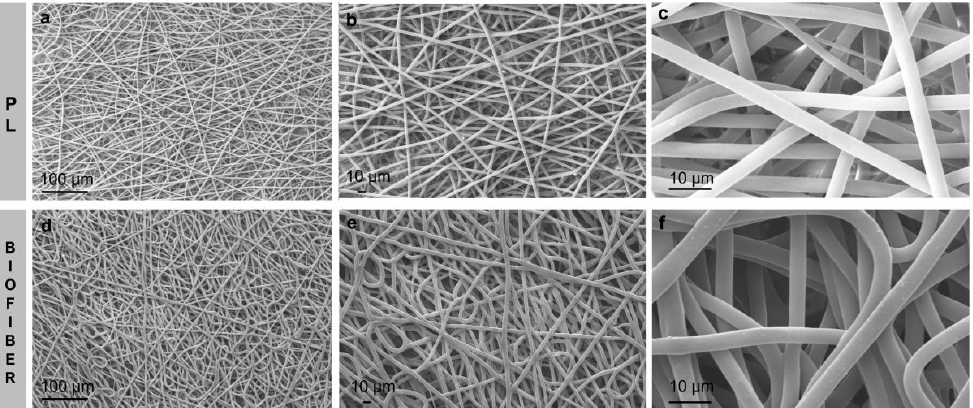
Figure 4. Representative SEM images of PL ( a – c ) and Biofiber ( d – f ) at different magnification 500 X-1.0 KX-5 KX.